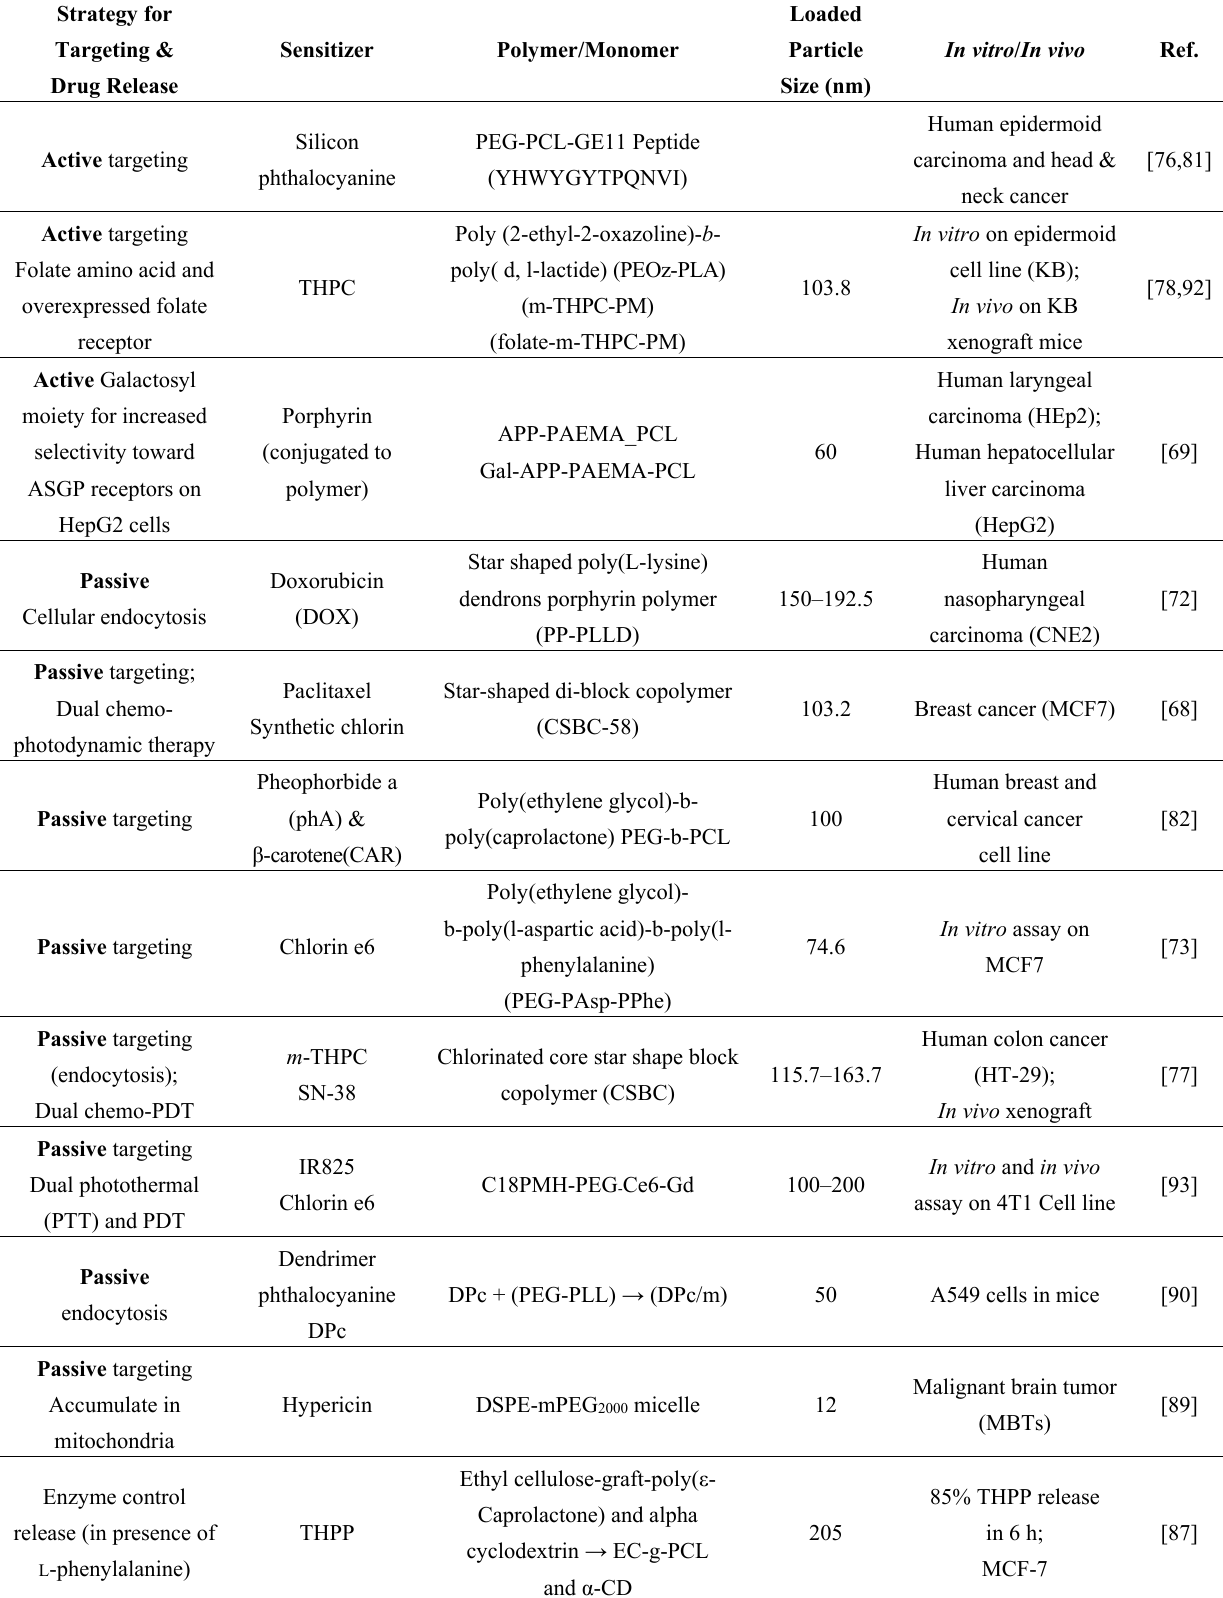
Table 2. Examples of polymeric micelles/micelles tested in vitro and in vivo for PDT.